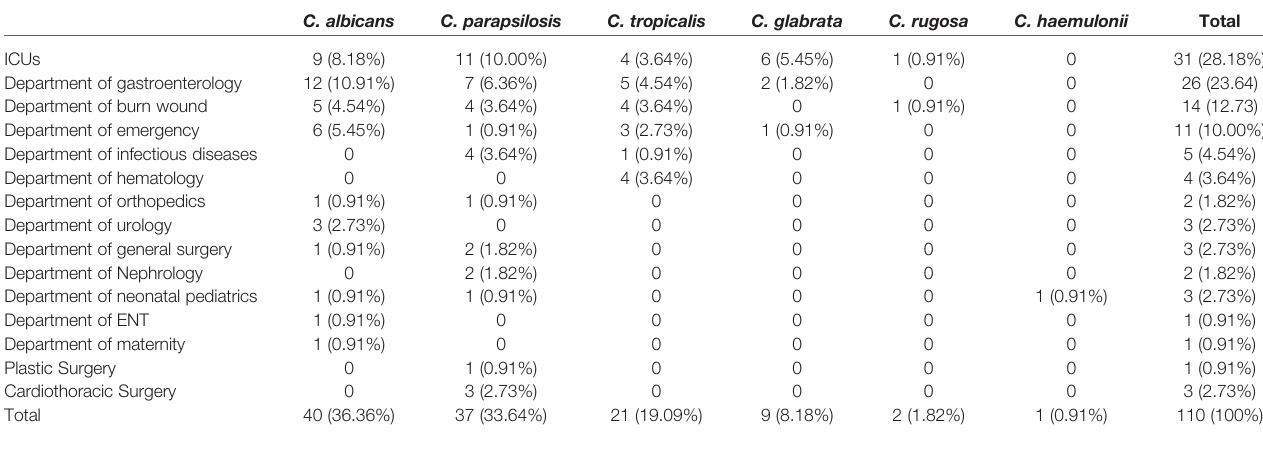
TABLE 1 | Distribution of Candida isolates by a source of isolation.